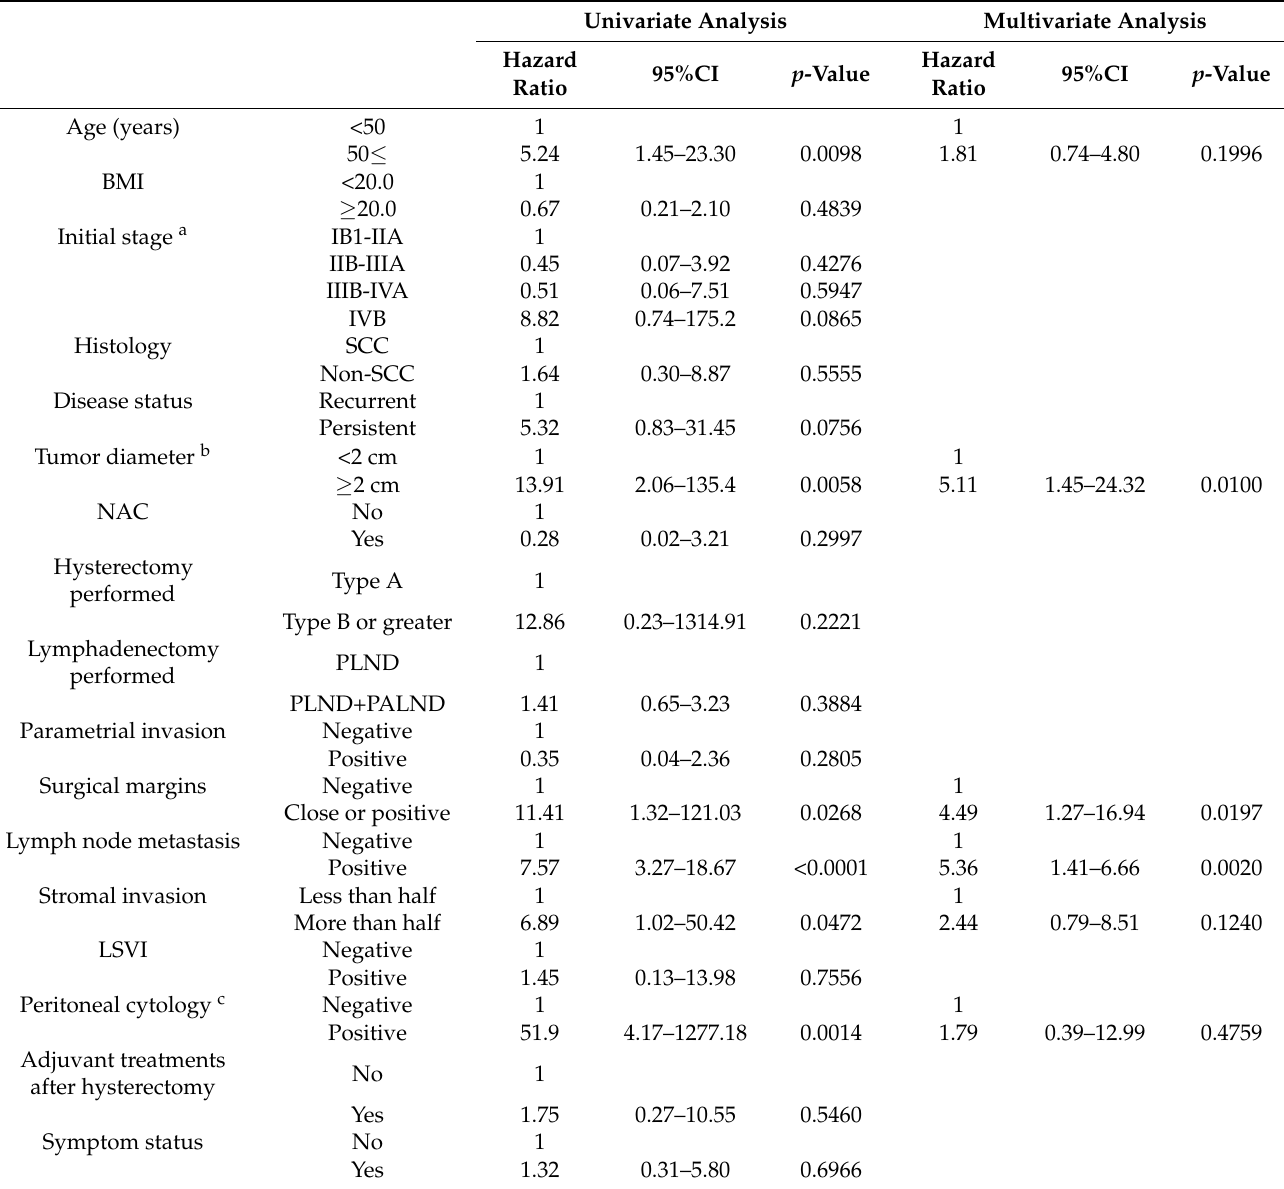
Table 3. Univariate and multivariate analysis of prognostic factors for post-operative recurrence. Univariate Analysis Multivariate